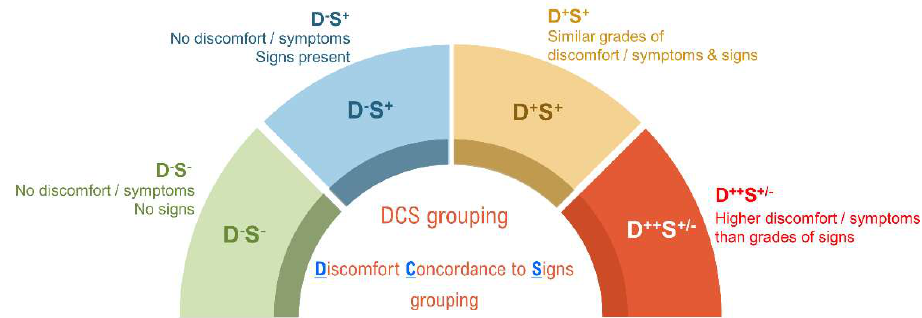
Figure 1. Discomfort concordance to signs (DCS) grouping. Schematic representation of the various groups under which the study subjects were categorized based on the concordance between the status of discomfort/symptoms (D) and signs (S). Group 1 (D - S - ) include subjects without discomfort/symptoms (OSDI score: <12) and no clinical signs (TBUT: ≥10 s, Schirmer’s test: ≥10 mm/5 min), hence, presumed as normal or control subjects. Group 2 (D - S + ) include subjects without discomfort/symptoms (OSDI score: <12) but present with signs (TBUT: <10 s and/or Schirmer’s test: < 10 mm/5 min). Group 3 (D + S + ) include subjects with similar grades of discomfort/symptoms and signs. Group 4 (D ++ S +/- ) included subjects in whom the discomfort/symptom grade is higher than the grade/severity of signs. OSDI severity scale (Normal < 12; Mild, 13–23; Moderate, 24–32; Severe > 32). TBUT severity scale (Normal ≥ 10 s; Mild 7 – 9 s; Moderate 5 – 7 s; Severe < 5 s). Schirmer’s test severity scale (Normal ≥ 10 mm/5 min; Mild 7 – 9 mm/5 min; Moderate 5 – 7 mm/5 min; Severe < 5 mm/5 min).